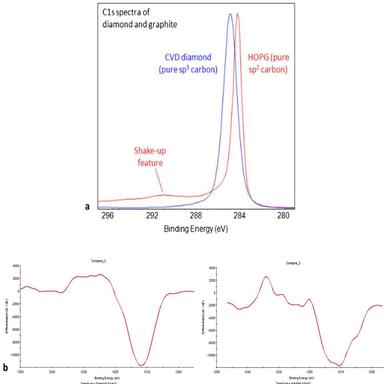
Data from reference: 10a. C1s spectra of diamond and graphite; 10b. CKLL spectra (differentiated) of diamond and graphite.